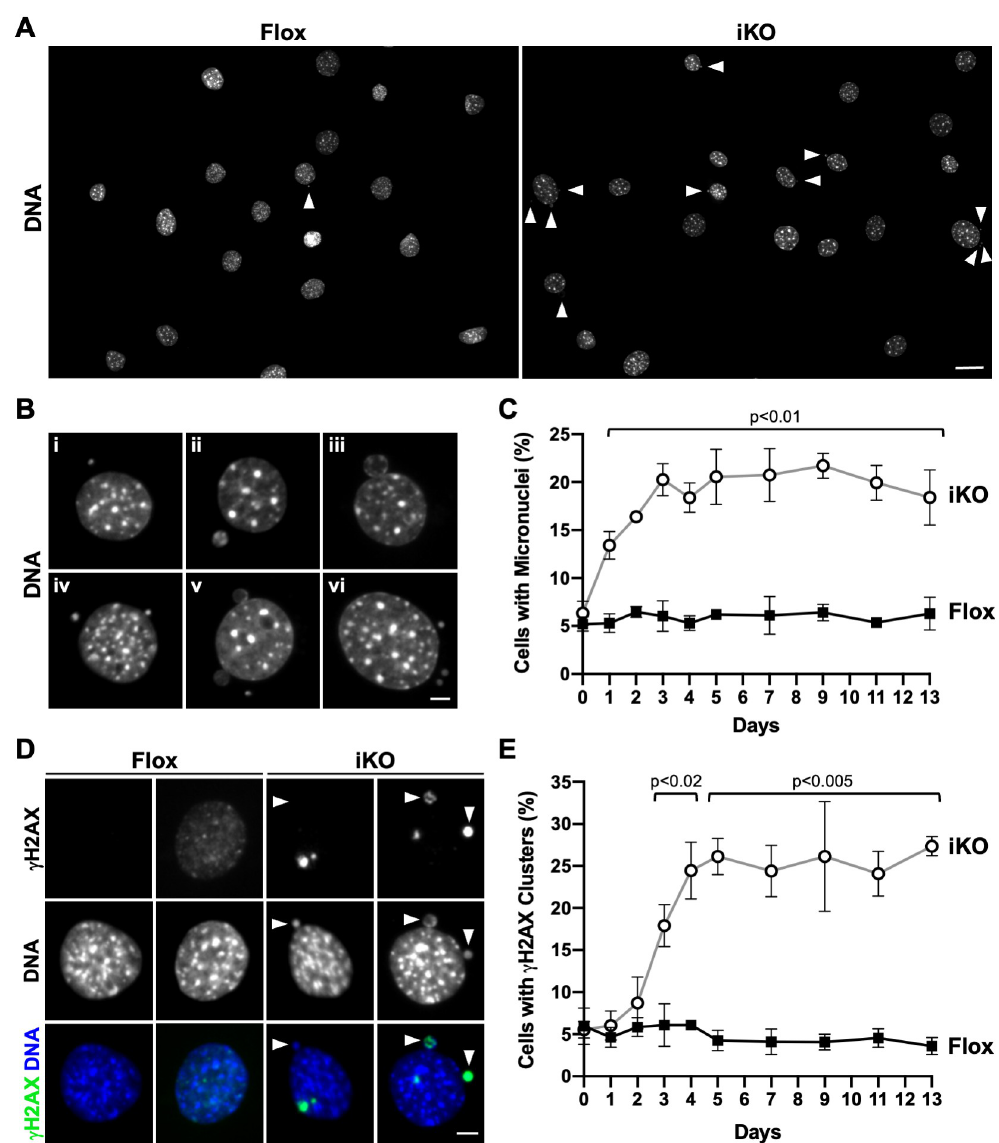
Fig 4. Arp2/3 complex depletion leads to the biogenesis of cytoplasmic micronuclei and prominent clusters of DNA damage. (A) Mouse fibroblasts were treated with DMSO (Flox) or 4-OHT (iKO) for 6d, fixed at 7d, and stained with DAPI (DNA). Arrowheads point to micronuclei. Scale bar, 25 μ m. (B) Magnifications show different micronucleus phenotypes in iKO cells. (vi) is the far-right cell from panel A. Scale bar, 5 μ m. (C) The % of cells with micronuclei was quantified over a 13d period following DMSO or 4-OHT exposure. Each point represents the mean % ± SD from n = 3 experiments, except for the 2d and 4d timepoints, which are from n = 2 experiments (432–631 cells per point in each experiment). (D) Flox and iKO cells were fixed at 7d and stained with a γ H2AX antibody (green) and DAPI (blue). Magnifications show no or diffuse γ H2AX staining in Flox nuclei and intense γ H2AX clusters in iKO cell nuclei and micronuclei. Scale bar, 5 μ m. (E) The % of cells with γ H2AX clusters was quantified over a 13d period following DMSO or 4-OHT exposure. Each point represents the mean % ± SD from n = 3 experiments, except for 2d and 4d timepoints, which are from n = 2 experiments (432–631 cells per point in each